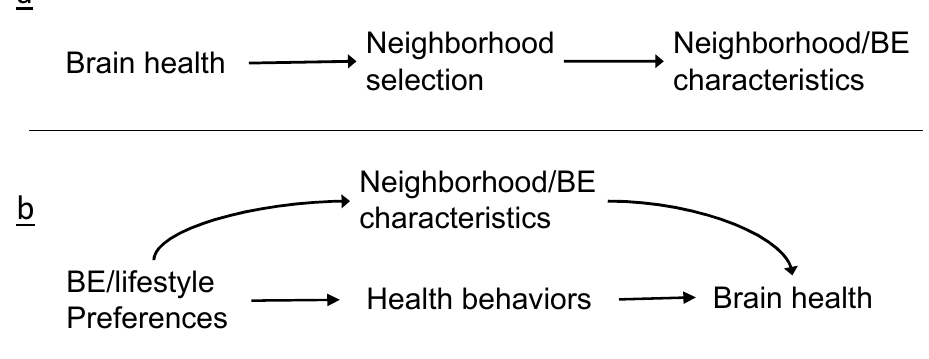
Figure 1. Illustration of relationship between neighborhood/built environment (BE) and brain health in the case of bias by ( a ) reverse causation; ( b ) self-selection by individual preferences.